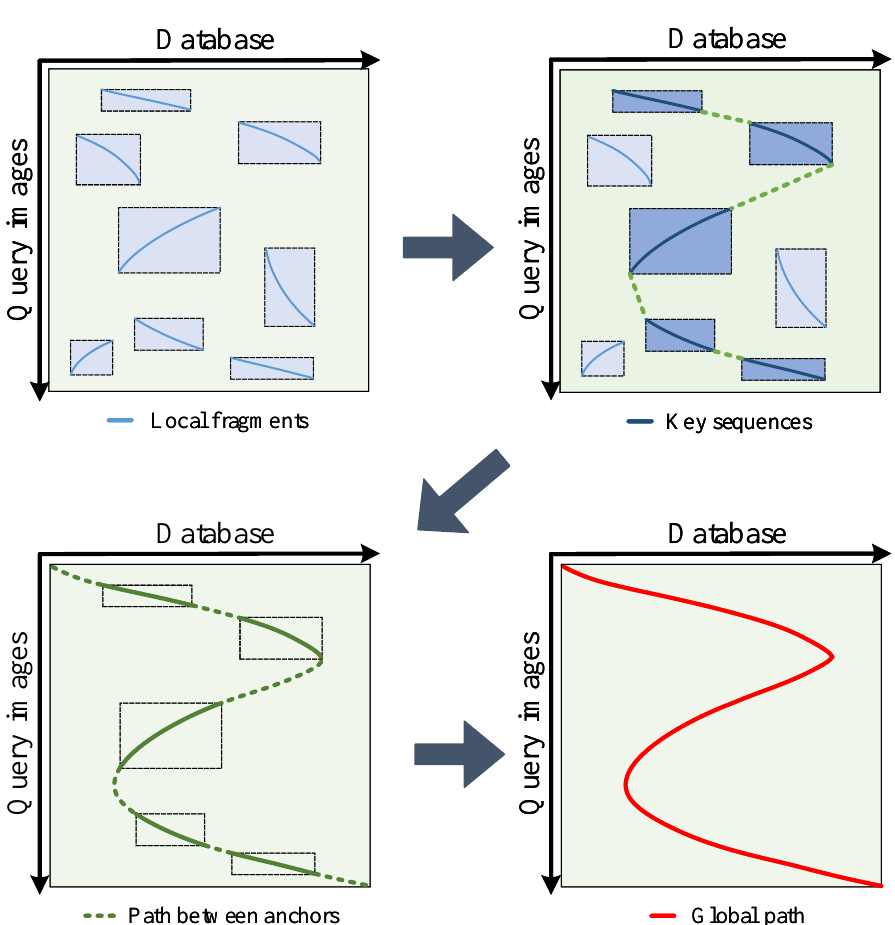
Figure 1. The procedure of the proposed approach. First, local fragments are detected from the similarity matrix using the local alignment method (Section 3.2). Second, the subset of the local alignments is found by the rectangle chaining algorithm that maximizes the total similarity under the motion constraint of the mobile robot (Section 3.3). Then, the path between anchors are calculated using the local alignment method. Finally, the most likely path of the robot is determined using the global aligner (Section